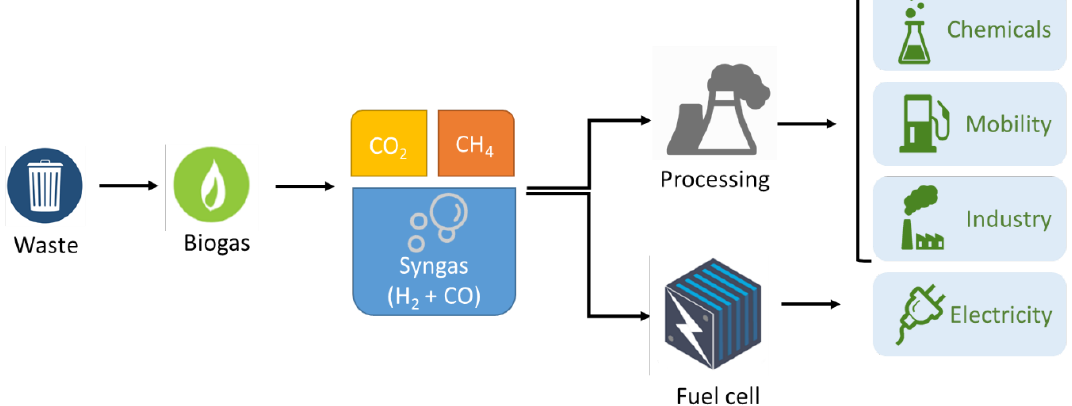
Figure 1. Block flow diagram illustrating the potential of utilising organic waste to generate ‘green energy’ .